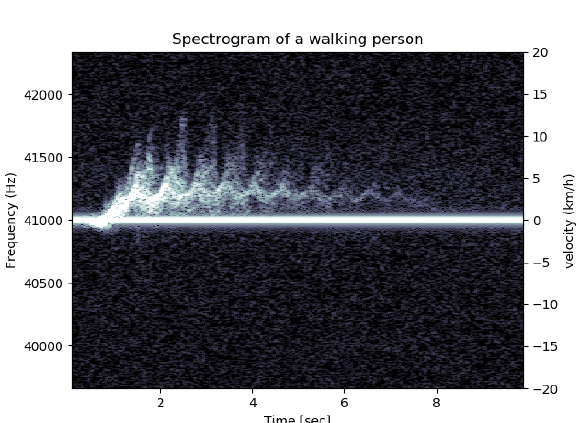
Figure 1. This figure shows the spectrogram of a walking person. Brighter colours correspond to higher presence of the